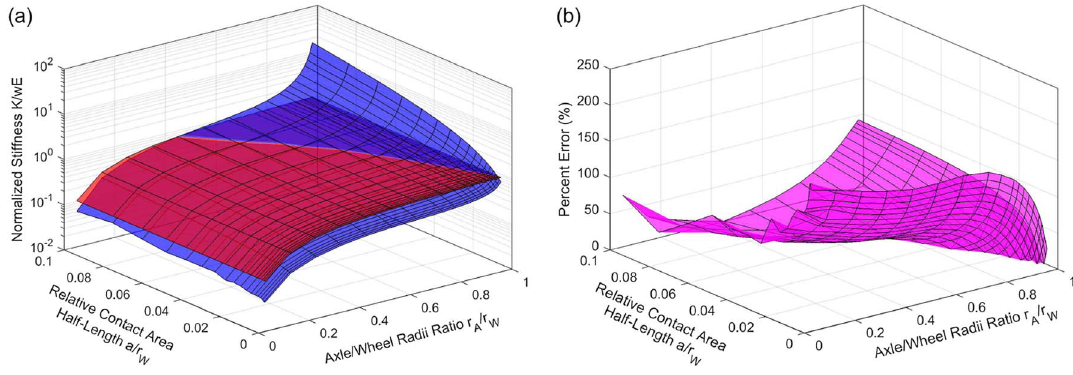
Figure 12. (a) Normalized wheel stiffness: FE model results (blue) vs. an equivalent trapezoidal prism (red). Plotted on a logarithmic z -scale (base 10). (b) Percent error between the FE model results and equivalent trapezoidal